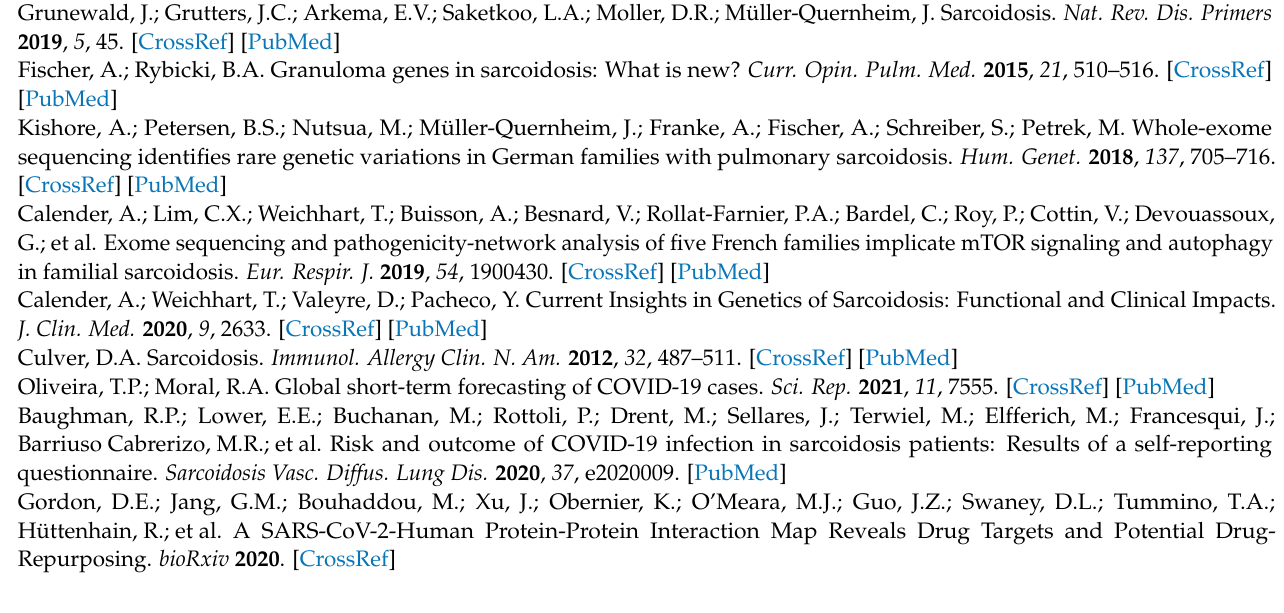
families. Table S2: The list and brief description of genes sharing rare (MAF < 0.05) and pathogenic mutations in the control series. Table S3: Intragenic variants of genes identified in familial sarcoidosis and belonging to the SARS-CoV2 host-pathogen Gordon Hoffmann interactome (GHI) (the F-SARC- CoV